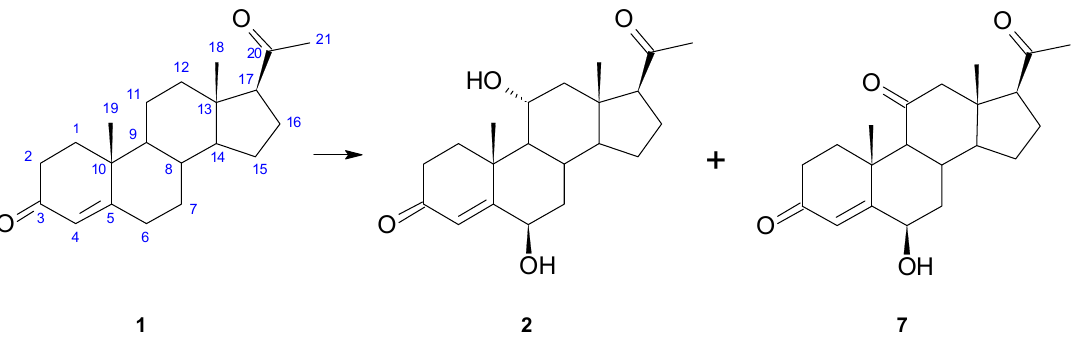
Figure 1. Transformation of progesterone ( 1 ) in the culture of Isaria farinosa KCh KW1.1. After a 3-day incubation of 100 mg of progesterone ( 1 ) in Isaria farinosa KCh KW1.1 culture, 32.9 mg of 6 β ,11 α -dihydroxyprogesterone ( 2 ) and 4.1 mg of 6 β -hydroxy-11-oxo- progesterone ( 7 ) were isolated.